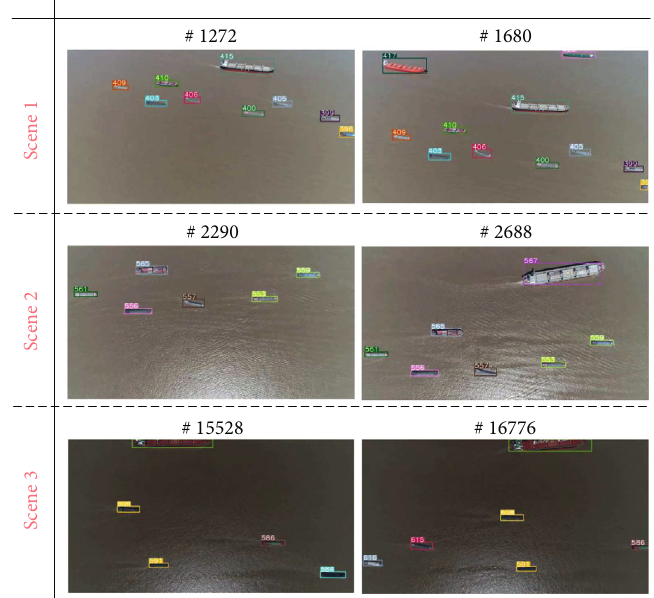
Figure 9: Multiscene ship detection and tracking Figure 10. Moreover, mean absolute error (MAE) and mean